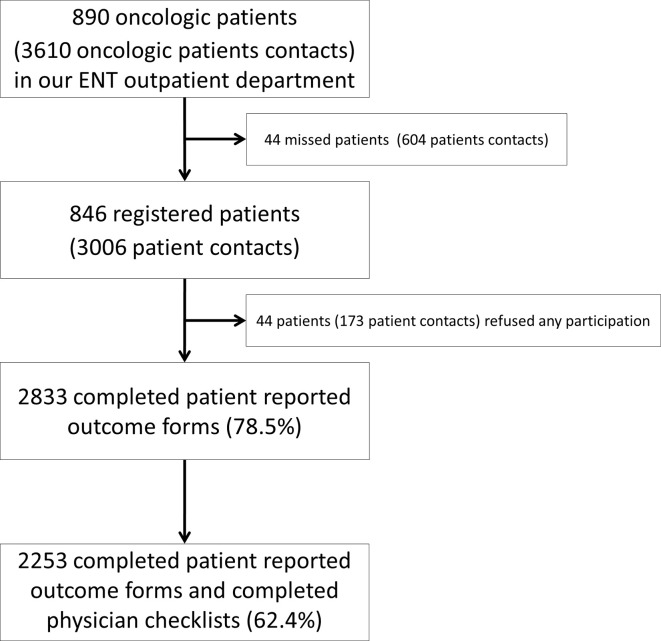
Flowchart of patient recruitment in our clinic from 7/2013 until 7/2017.